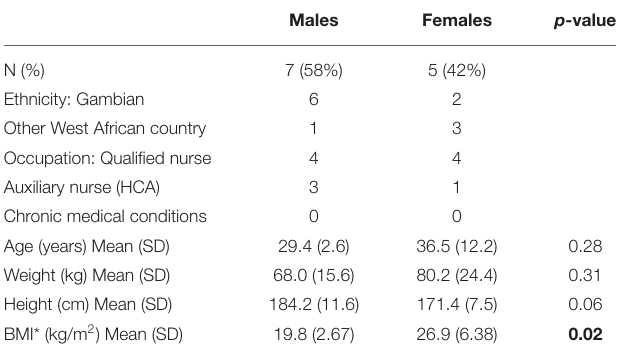
TABLE 1 | Mean (SD) demographic and anthropometric measurements of